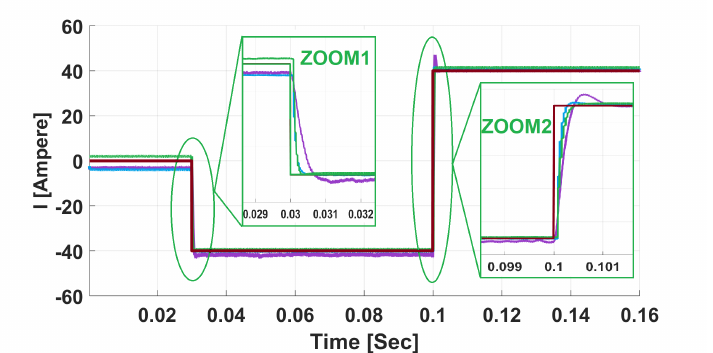
Figure 16. Battery current evolution during charge phase for DAB with TPS (blue curve), DAB with SPS (green curve) and buck–boost converter (violet curve). Red curve represents the current